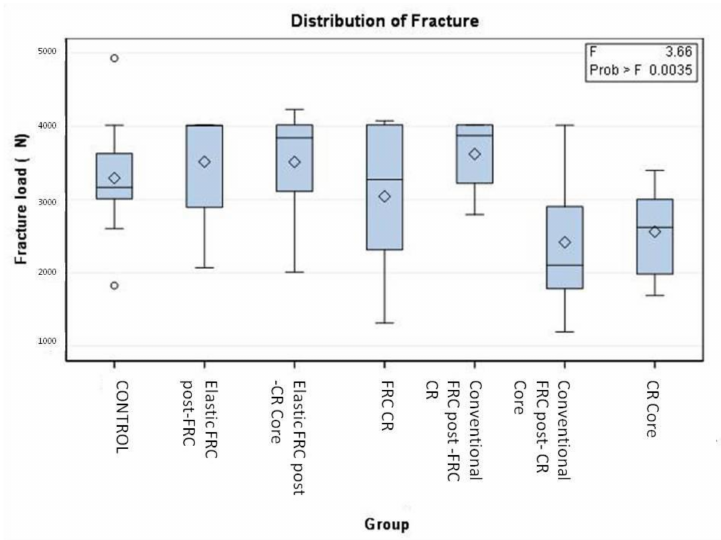
Figure4. Box plots of fracture resistance values (N)of thestudy groups after bendingtest. The horizontal line in each box represents median value.